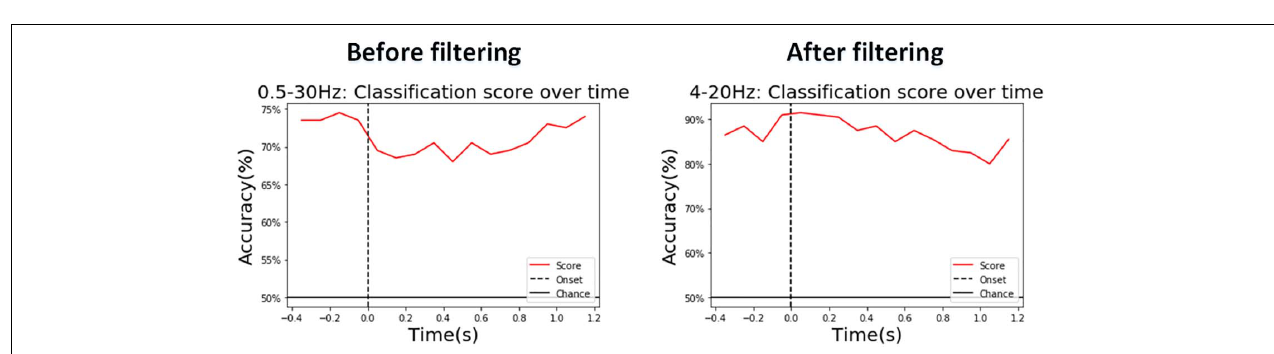
FIGURE 12 | The single-target classification accuracy over all subjects for the vibration and electrical mode.